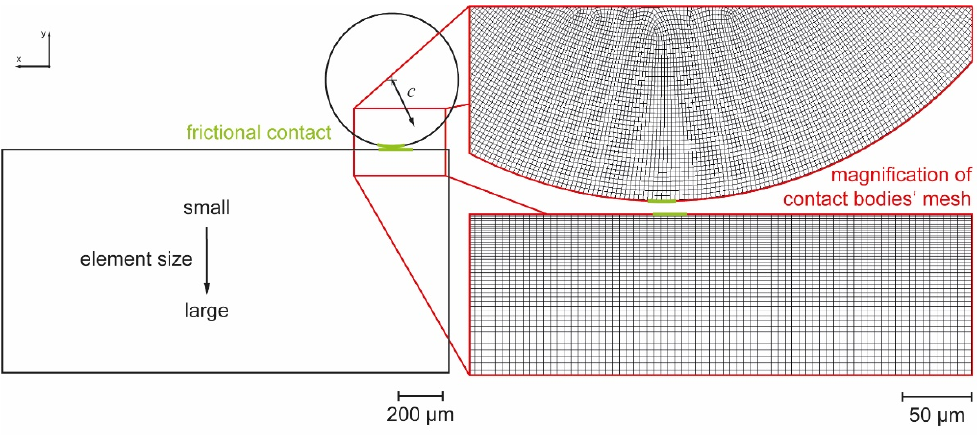
Figure 5. Mesh and boundary conditions of explicit dynamic particle model.